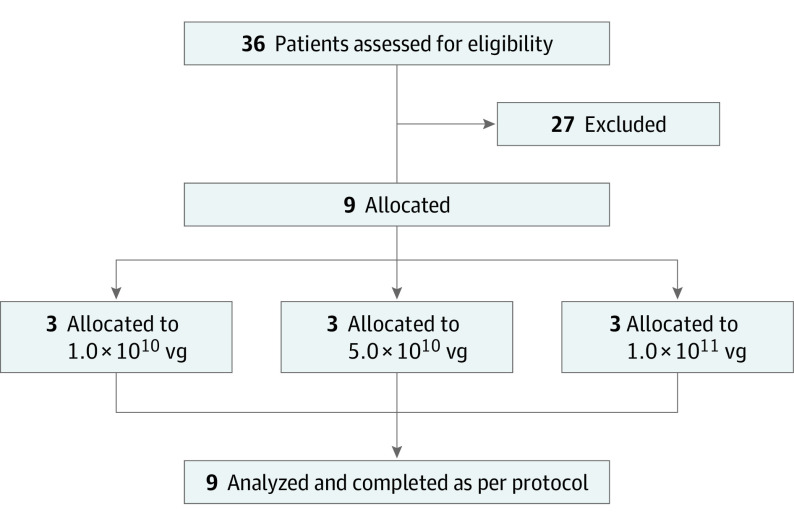
CONSORT Flow Diagramvg indicates vector genomes.